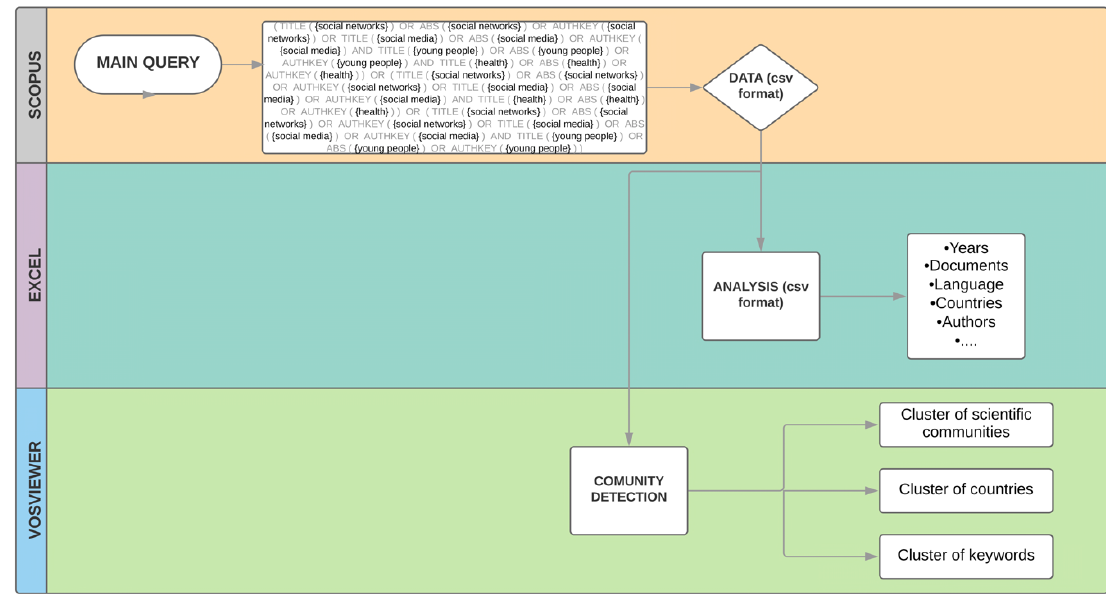
Figure 1. Methodology structure.